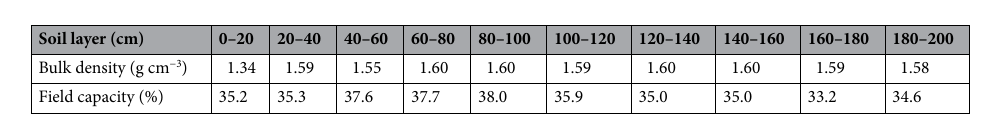
Table 1. The soil bulk density and field capacity in 0–200 cm soil layers in the experimental plots.